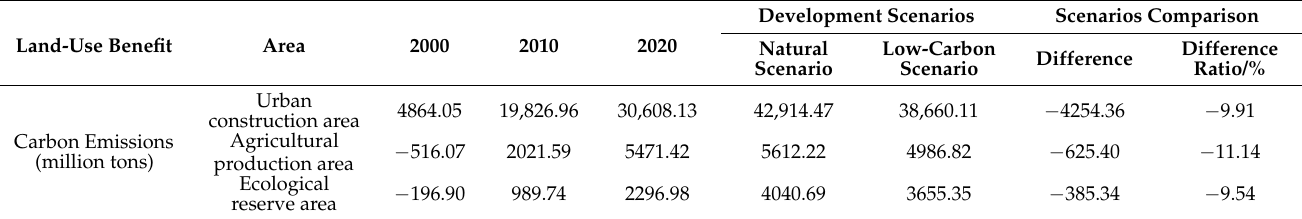
Table 10. Comparison of carbon emissions in different development scenarios.